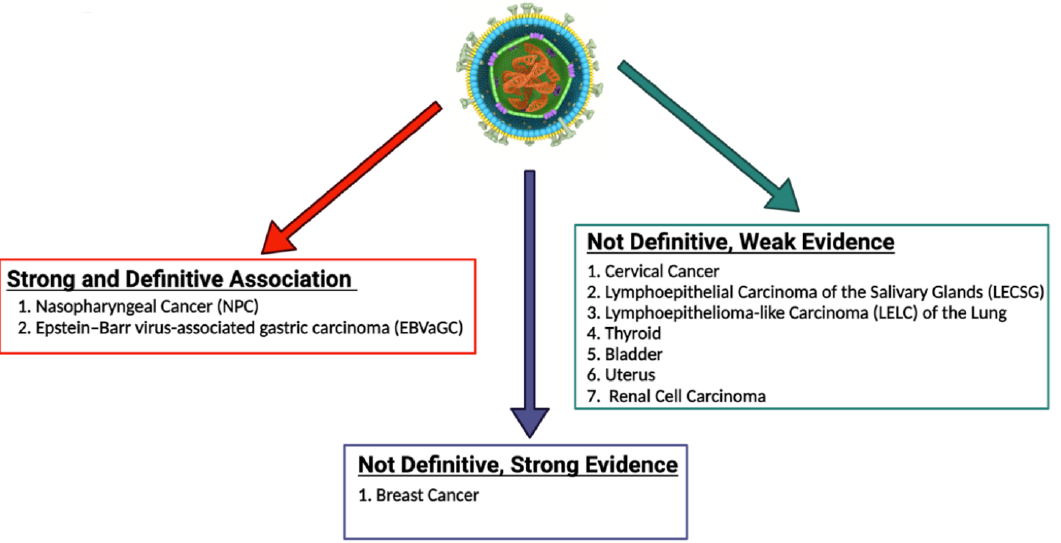
Figure 1. EBV-associated epithelial malignancies. EBV is associated with numerous malignancies with varying degrees of evidence. There is numerous evidence linking EBV to both nasopharyngeal carcinoma and gastric carcinoma. With regard to breast cancer, some studies provide strong evidence that EBV plays a role in the pathogenesis of breast cancer, while some studies call for more definitive evidence to be published. EBV has been less definitively associated with numerous other epithelial malignancies, including cervical cancer, lymphoepithelial carcinoma of the salivary glands, lymphoepithelioma-like carcinoma of the lung, thyroid cancer, bladder cancer, uterine cancer, and renal cell carcinoma [34 – 46]. The role of EBV in the pathogenesis of these cancers should be further explored and definitively established.